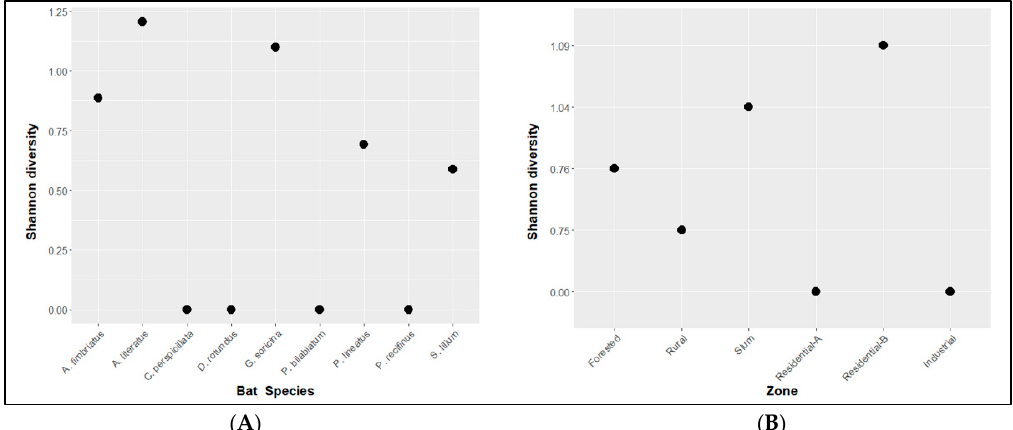
Figure 2. Relationship between Shannon diversity index for Staphylococcaceae isolated from skin swab samples and bat species ( A ; P = 0.43) and zone of collection ( B ; P = 0.41). Bat species are distributed alphabetically, and zones are distributed from the lowest to the highest degree of anthropization.